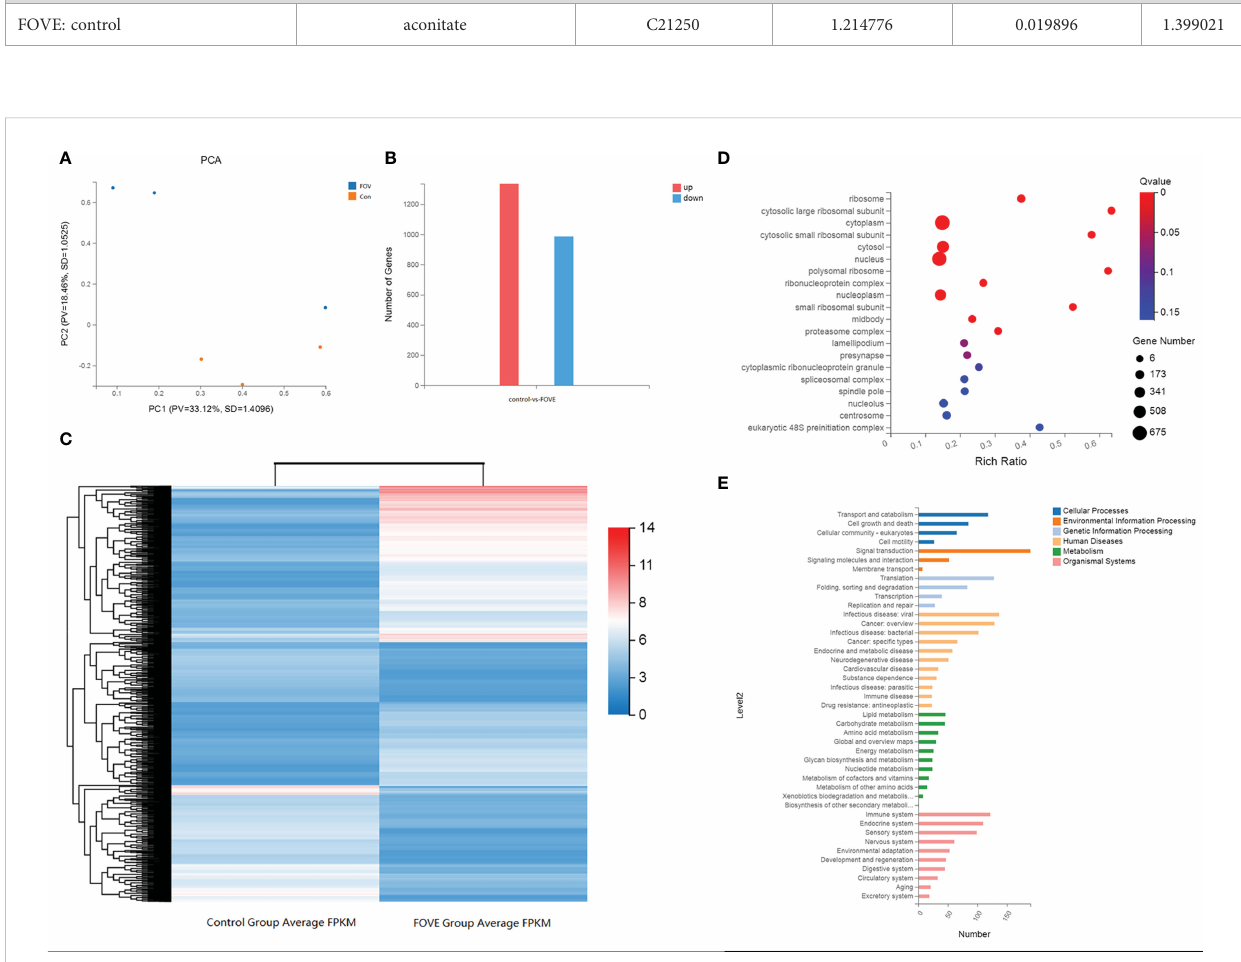
FIGURE 6 KEGG and GO analysis of differentially expressed genes. Principal component analysis (PCA) score plots of the two groups (A) . The number of differentially expressed genes (DEGs), red column = increased expression (n=1336) and blue column = decreased expression (n=987) (B) . Hierarchical clustering analysis of DEGs. Red denotes increased expression and blue denotes decreased expression (C) . Function analysis of differentially expressed genes (DEGs) between two treatment groups based on Gene Ontology (D) and KEGG pathway (E) analysis. D, The size of the dot designates the number of DEGs in the pathway, and the color of the dot corresponds to a different Q value (for the most enriched top 20 pathway terms). E, The ordinate is the enriched KEGG pathway term, and the abscissa is the number of DEGs for the term. Different colors are used to differentiate cellular processes, environmental information processing, genetic information processing, human diseases, metabolism and organismal